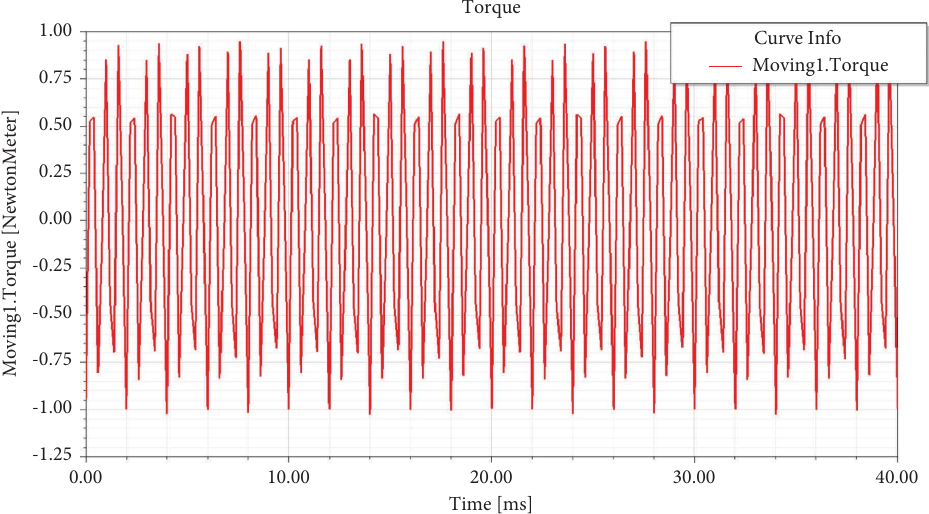
Figure 12: Reluctance torque curve of 4-pole 30-slot motor.